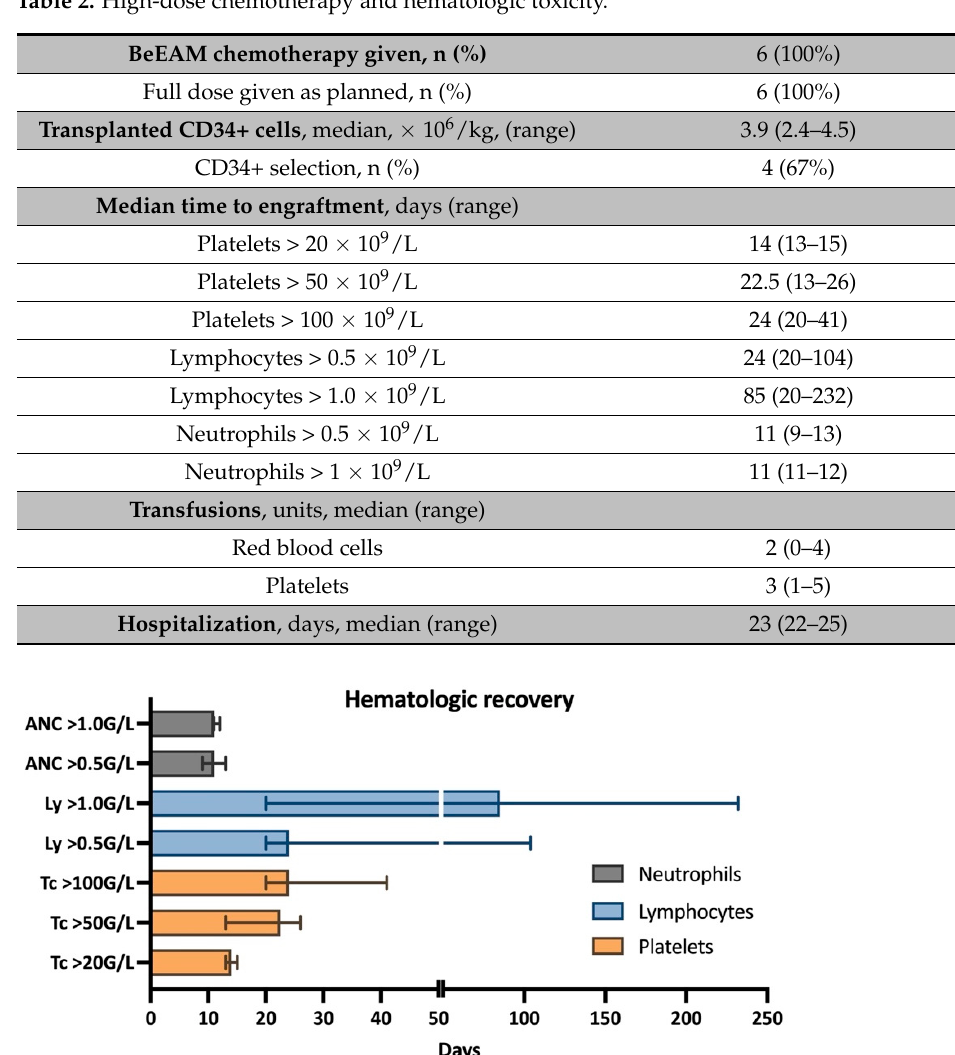
Table 2. High-dose chemotherapy and hematologic toxicity.